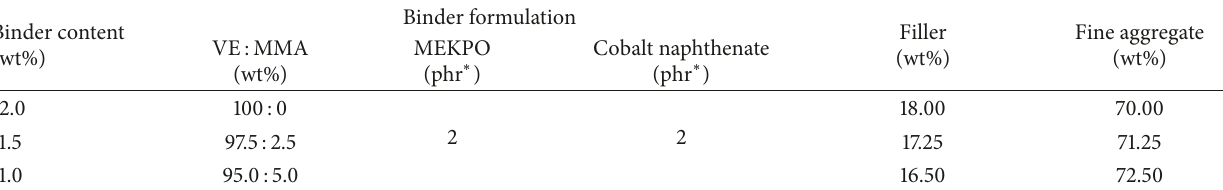
Table 8: Mix proportion of polymer concrete.